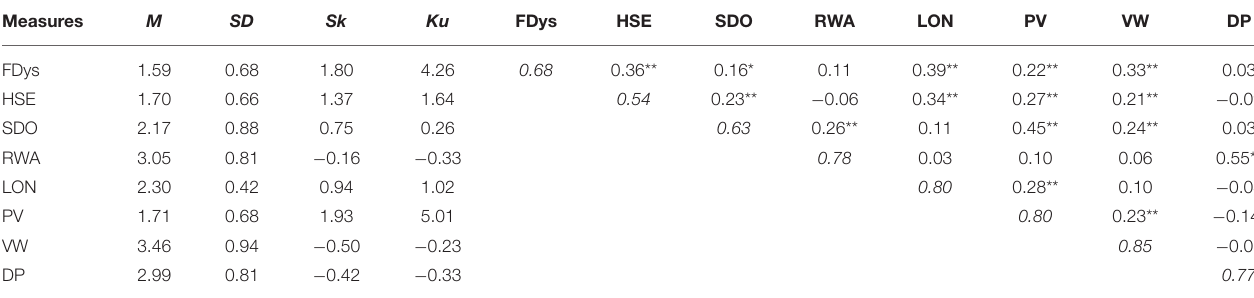
TABLE 1 | Descriptive statistics for measures used ( N = 271).